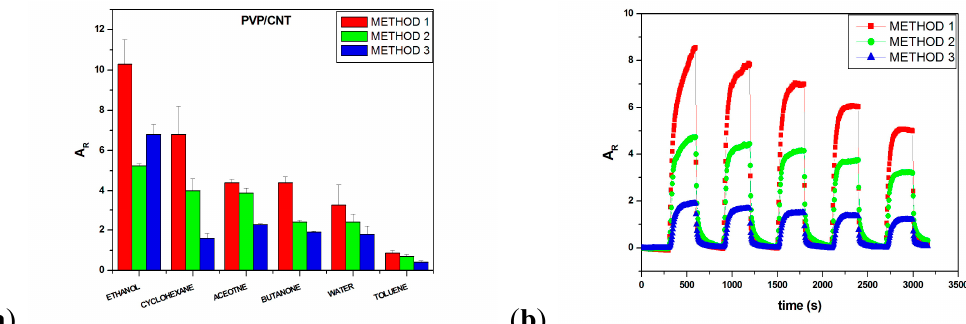
Figure 2. ( a ) Comparison of the A R (maximum amplitude) obtained with PVP-CNT vQRS exposed to six VOC depending on the fabrication method. M1: Drop casting of the polymer solution on a sprayed multi-walled carbon nanotubes (CNT) random network, M2: Spraying of a polymer solution on a sprayed CNT random network, and M3: Spraying of a CPC (PVP-CNT) solutions onto interdigitated electrode; ( b ) Responses of PVP-CNT to cyclohexane for vQRS prepared by the three methods.